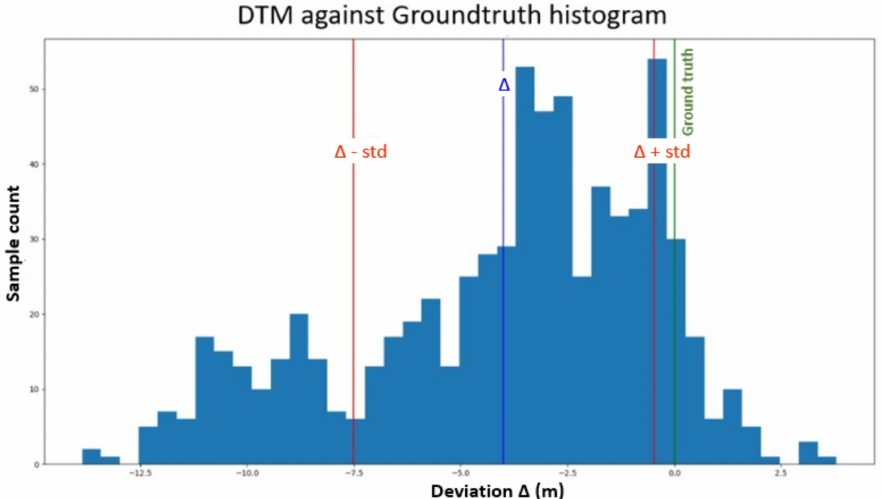
Figure 3. A rather uninspiring, although not uncharacteristic, histogram of a 500 sq.km AOI. The ≈ 4 m bias and 3.5 m Std are not compatible with a 2-m grid resolution (Sentinel-2 image—Traditional Lee et al. SDB model—NE Qatar).